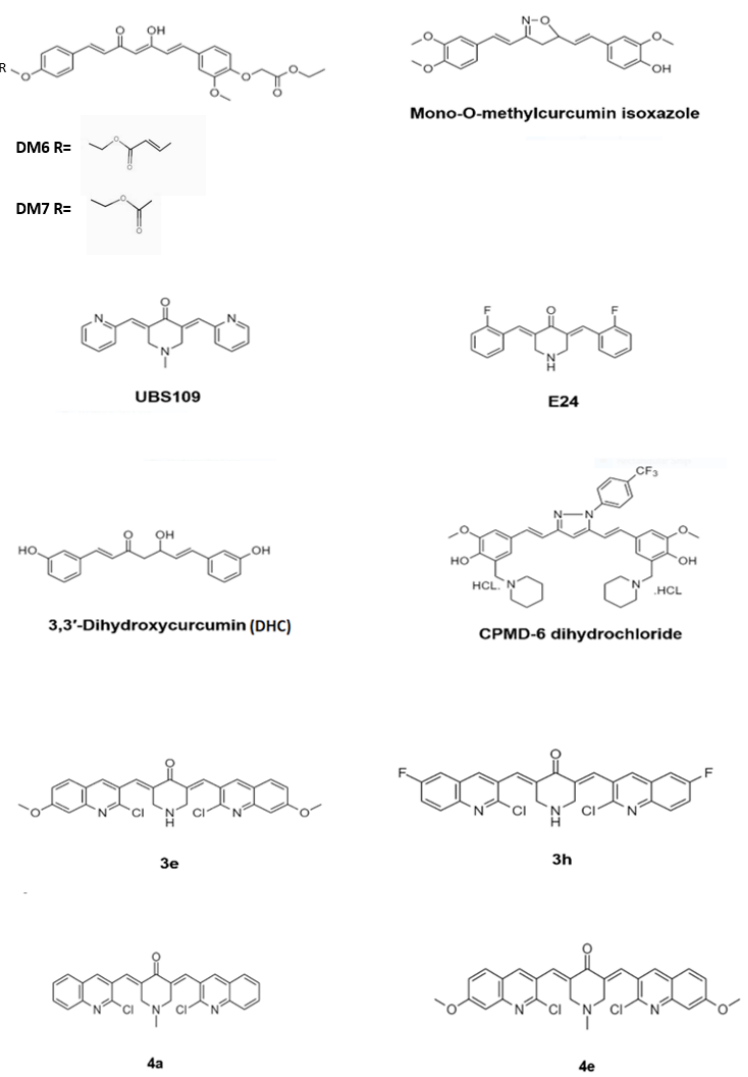
Figure 4. Chemical structure of the curcumin derivatives that have exhibited potent antimycobacte- rial activity.